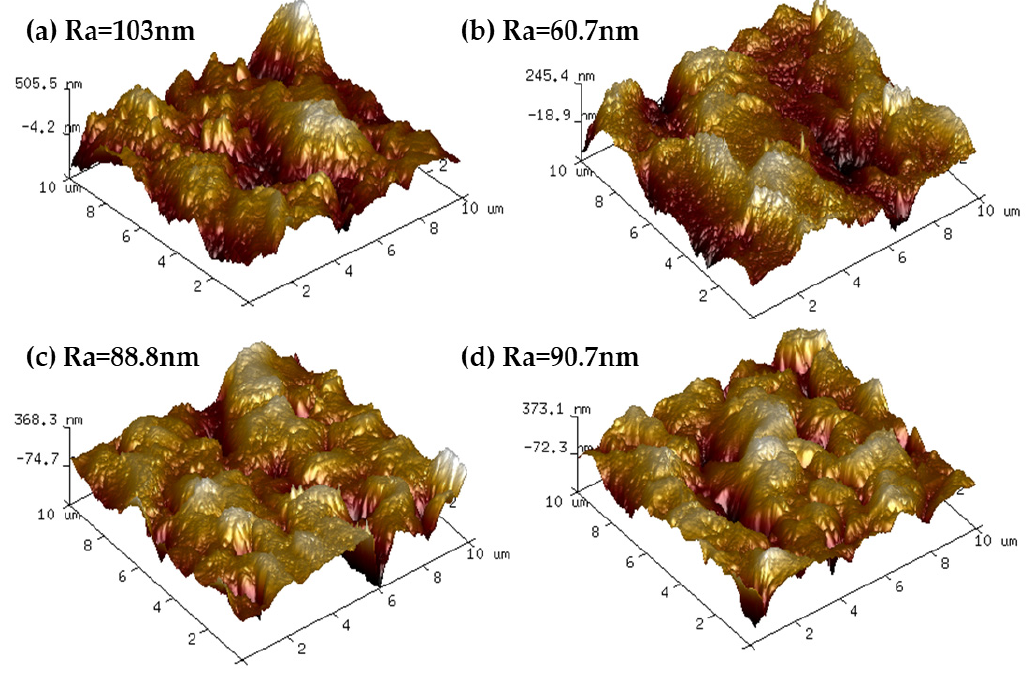
Figure 11. AFM images of PA66 and PA66/GO membranes, ( a ) P0, ( b ) P1, ( c ) P2 and ( d ) P3.